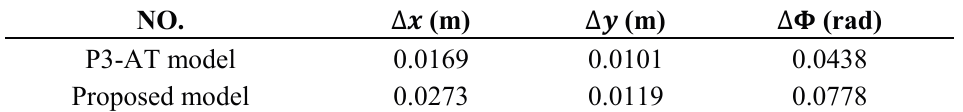
Figure 15. Dead-reckoning errors using the proposed model and the P3-AT model for an example path with the mobile robot. ( a ) Magnitude of position errors in X axis and Y axis; ( b ) position magnitude errors and heading errors. Table 4. Mean squared performance values of position and heading